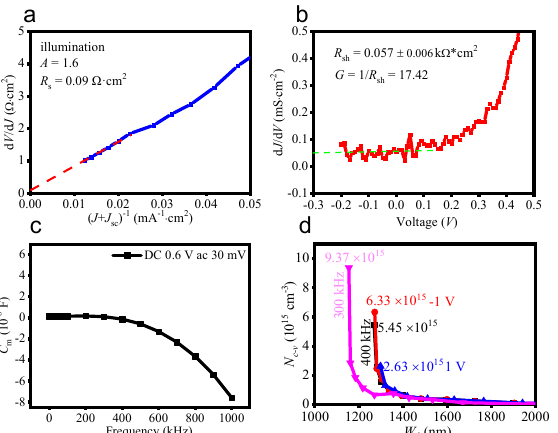
Figure 3. ( a ) dV/dJ~ ( J + Jsc ) − 1 curve and the derived R s and A for the CIGS solar cell. ( b ) dJ/dV~ V curve and the derived R sh and G for the CIGS solar cell. ( c ) C m − f curves for the CIGS solar cell with a −1 V pretreatment and without pre−treatment. ( d ) N c-v ~ W dep curve sot the CIGS solar cell at 300 and 400 kHz (1 V DC voltage pre−treatment, without a pre−treatment, −1 V DC voltage pre−treatment).